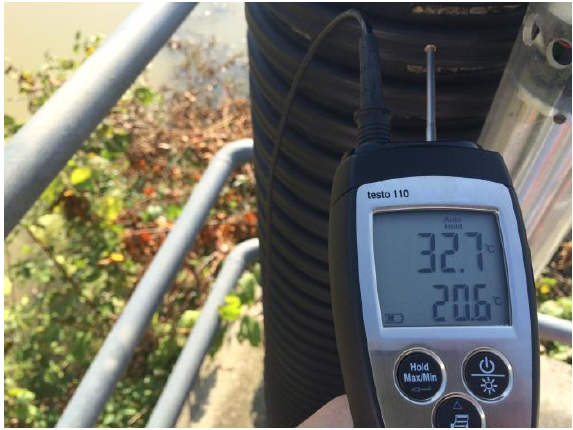
Figure 16. The measured temperatures on the sunny and shady sides of the reference point; the upper value shows the temperature on the sunny side, while the lower value shows the temperature on the shady side.